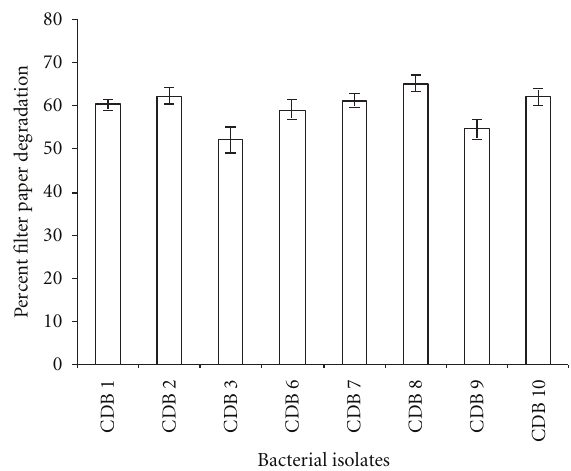
Figure 4: Percent filter paper degradation by various bacterial isolates obtained from termite, snail, bookworm, and caterpillar by gravimetric method. Maximum percentage of filter paper degradation was found to be 65.7% by CDB 8. Values in figure are means of three replicates with standard